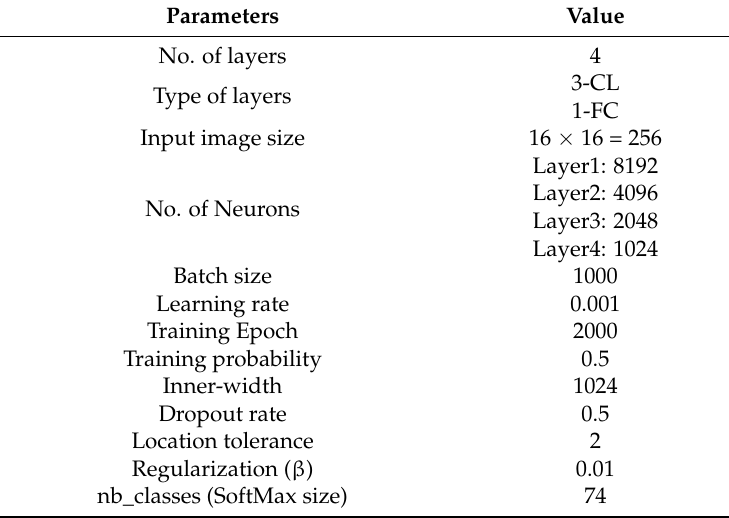
Table 1. Summary of parameters used in the deep learning